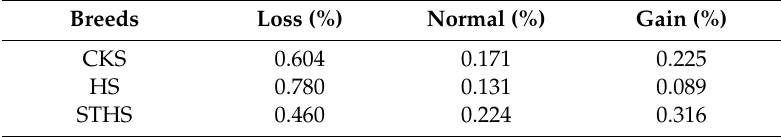
Table 2. Frequencies of di ff erent CNV types in three sheep breeds.